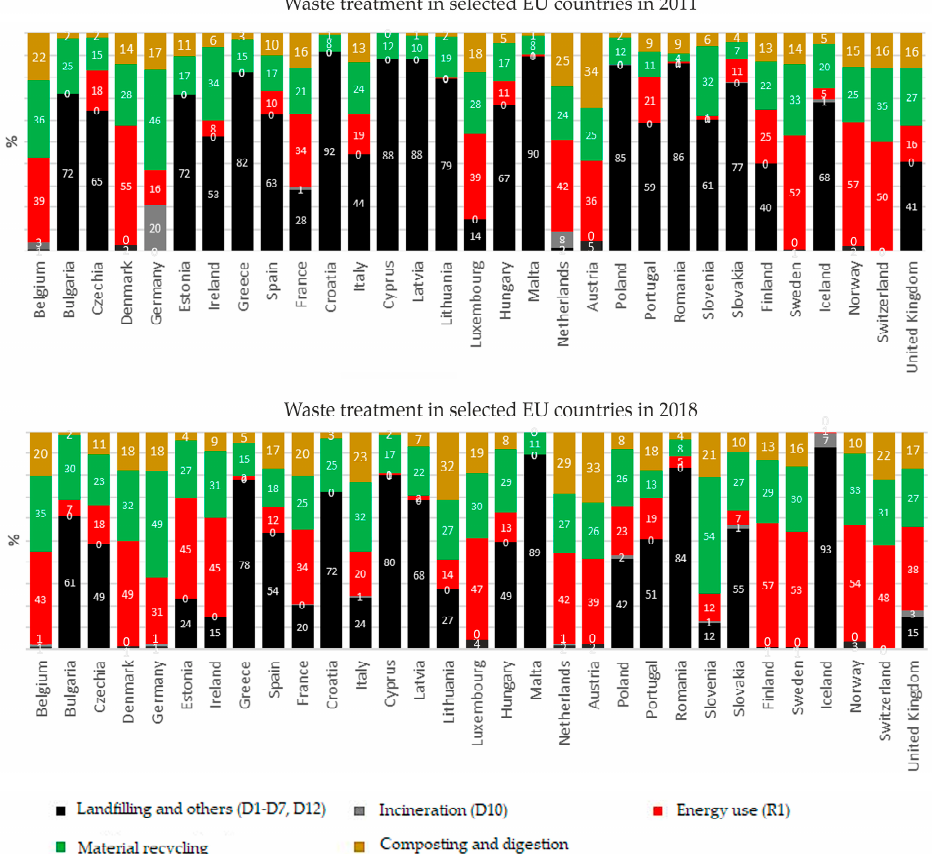
Figure 4. Comparison of municipal waste management in the EU in 2011 and 2018.